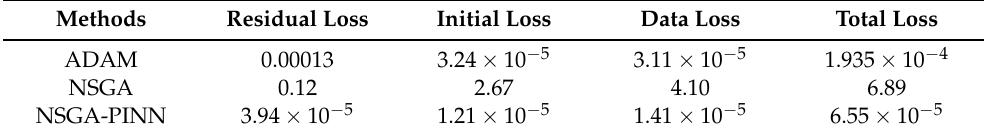
Table 1. Inverse pendulum problem: Each loss value from NN trained by using different train- ing